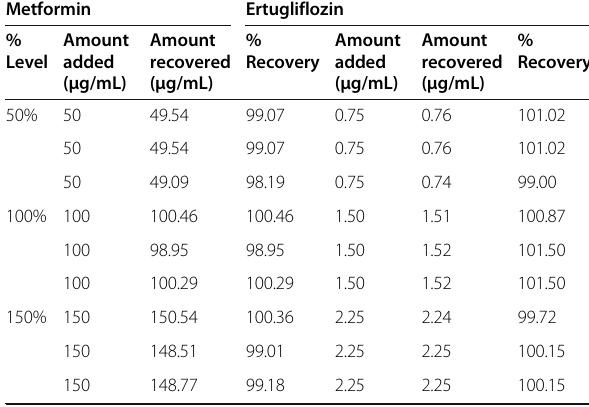
Table 3 Recovery results of Metformin and Ertugliflozin